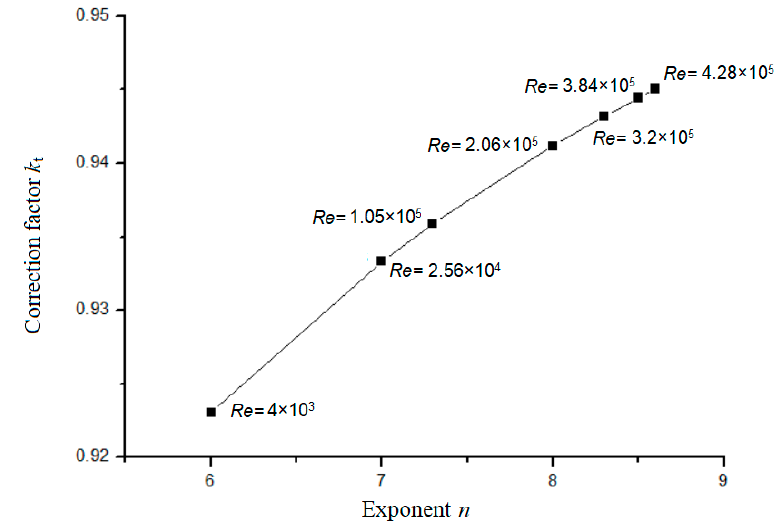
Figure 3. Correction factor for a turbulent flow.